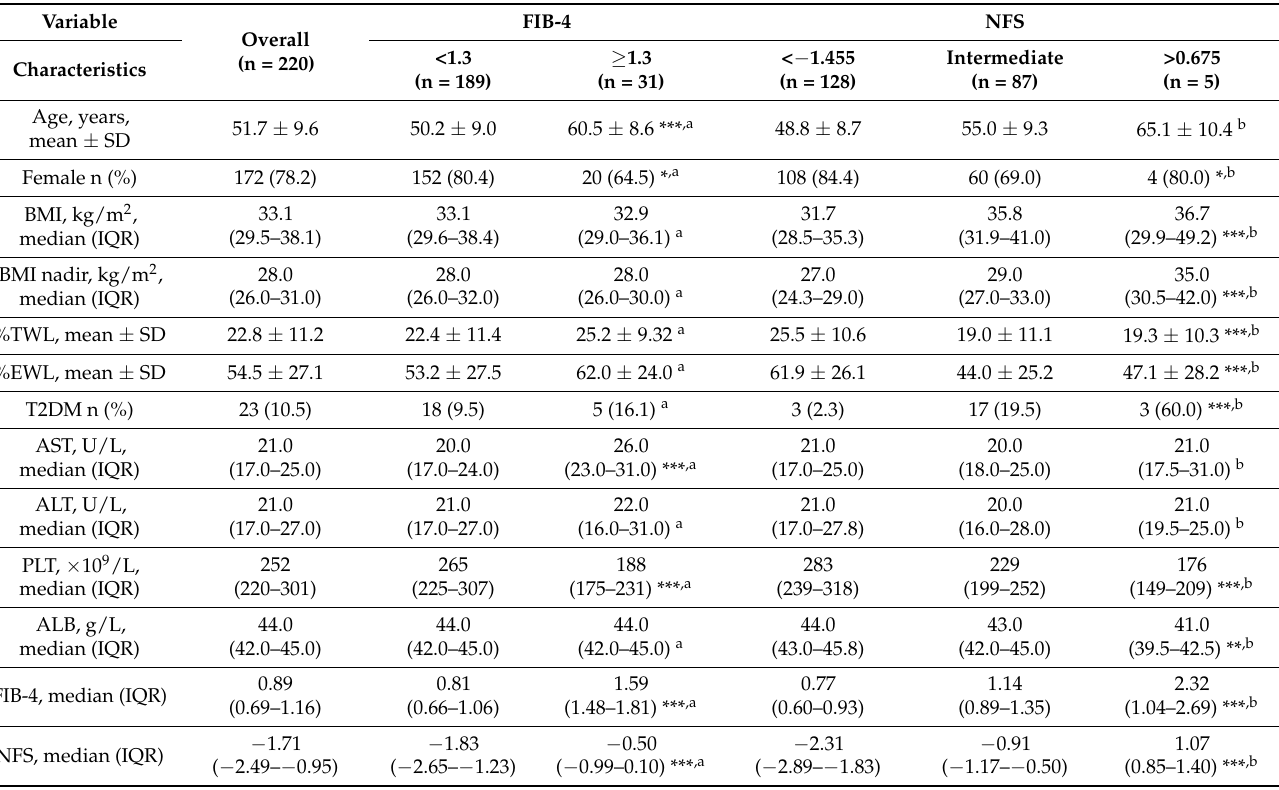
Table 2. Study population 11.6 years after Roux-en-Y gastric bypass